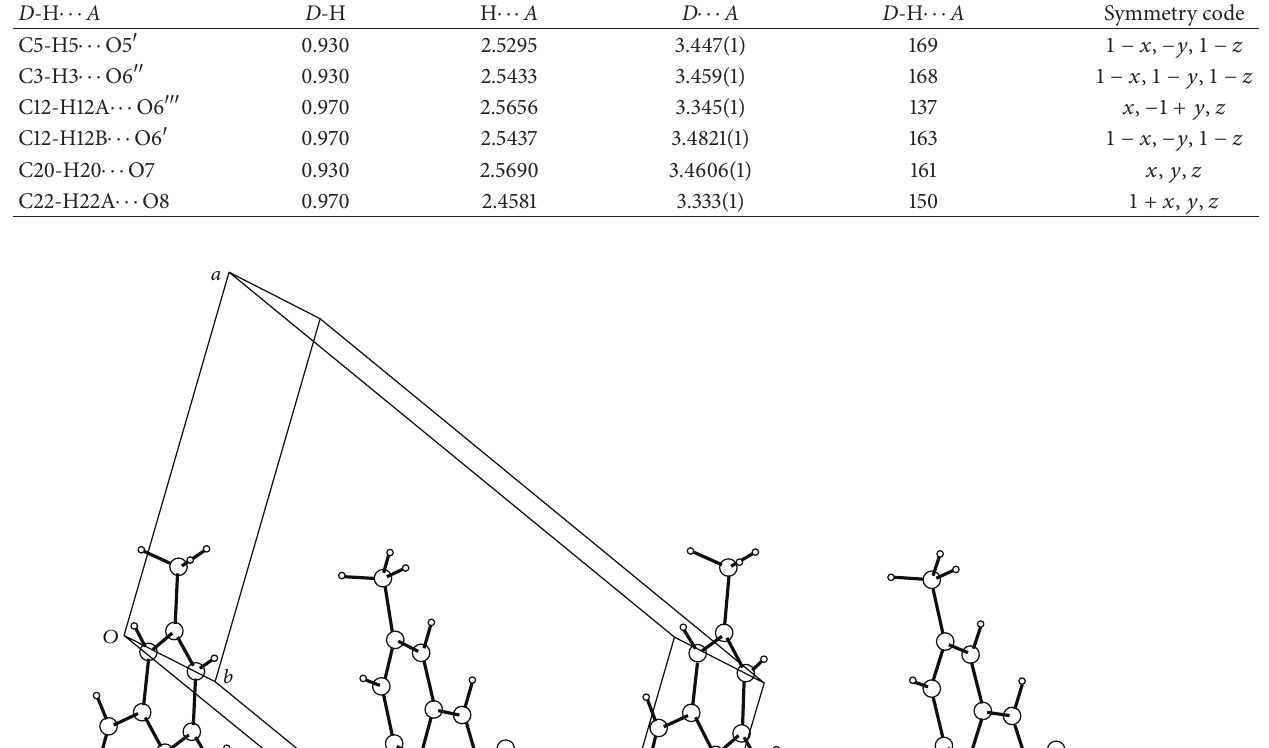
Table 3: Hydrogen-bonding geometric parameters (˚A and ∘ ) of [ { Cu 2 (tidf)( 𝜇 -NO 3 ) } ∞ ]ClO 4 .